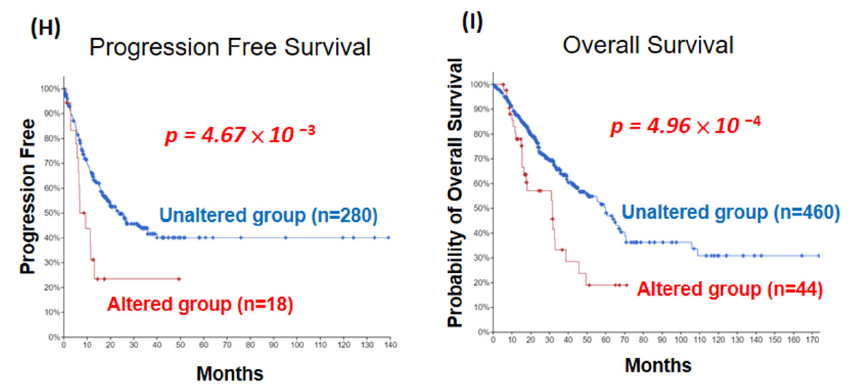
Figure 5. BRAF , SMAD4 , and TP53 genetic variants in patients with colorectal carcinoma. ( A ) Oncoprint indicates genetic alterations in BRAF , SMAD4, and TP53 in patients with colorectal carcinoma, respectively. Colors indicate the type of genetic alterations (green: mutation; purple: structure variation; red: amplification, and gray: multiple alterations) and different cohorts below the oncoprint. ( B – D ) Alteration frequency of BRAF , SMAD4 , and TP53 in colorectal carcinoma in five cohorts. CAN = copy number alterations. ( E ) Distribution of patients with BRAF , SMAD4 , and TP53 genetic variants. ( F , G ) The effect of variants in BRAF , SMAD4 , or TP53 on progression-free survival and overall survival were analyzed from five colorectal cancer databases. ( H , I ) The effects of the simultaneous occurrence of BRAF , TP53 , and SMAD4 mutations on progression-free survival and overall survival were analyzed from five rectal cancer databases.